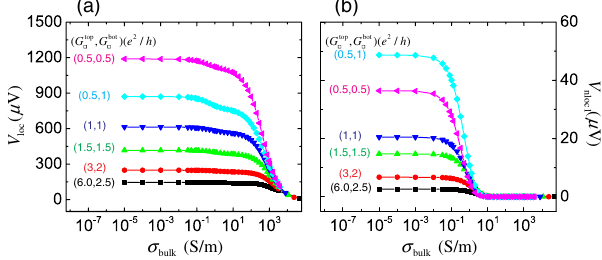
FIG. 2. Numerical simulation results of the effect of σ (a) V and (b) V loc